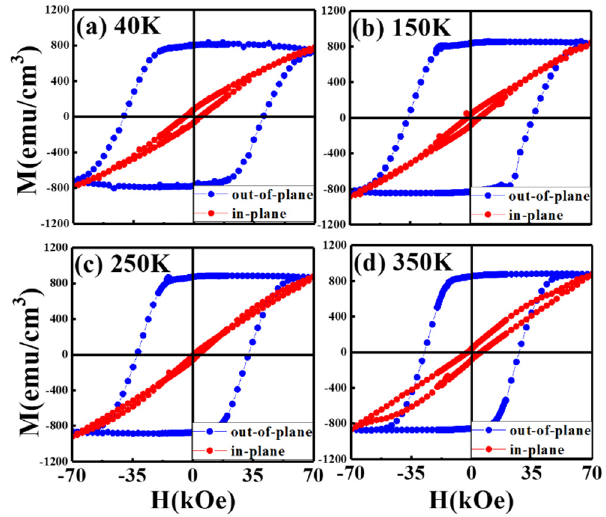
Figure 3. Out-of-plane and in-plane field-dependent magnetization loops of FePt (B, Ag, C) (6 nm)/MoC/MgTiON/CrRu films measured at ( a ) 40 K, ( b ) 150 K, ( c ) 250 K, ( d ) 350 K. The saturation magnetization (M s ) of two samples is around 800 emu/cm 3 , and the remanence ratio (M r /M s ) is almost 1.0 for two samples. When the measured temperature is down to 40 K, the out-of-plane coercivity is around 40 kOe for both samples. Only the 6 nm thick FePt(B, Ag, C) film measured at 350 K shows a wide-up hard-axis loop that may be due to thermal